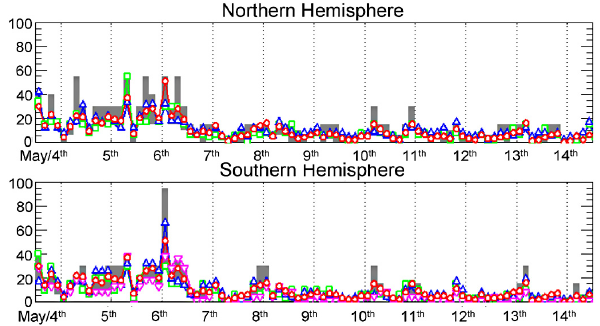
Fig. 8. αλ indices of magnetic activity in N2 (blue triangle) and N3 (green square) in the Northern Hemisphere (top) and in S1 (blue triangle), S2 (green square) and S3 (purple inverse triangle) in the Southern hemisphere (bottom) in the period from 4 to 14 May. The ET disturbance recorded over the Sichuan region and its conjugate area occurs on 6 May. Range of indices are indicated in grey by maximum and minimum indices. Global am-index is plotted in red circles. Vertical dotted lines correspond to 00:00:00UT of each